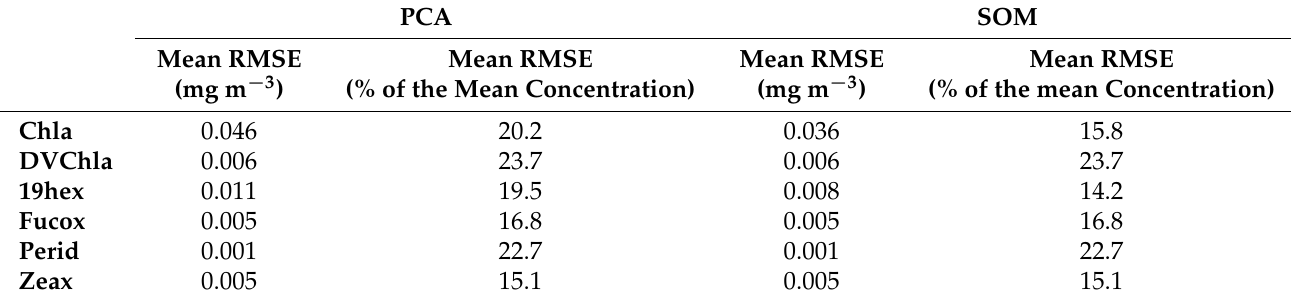
Table 4. Mean RMSE results for the PCA step of the method and the SOM step of the method. PCA SOM Mean RMSE (mg m − 3